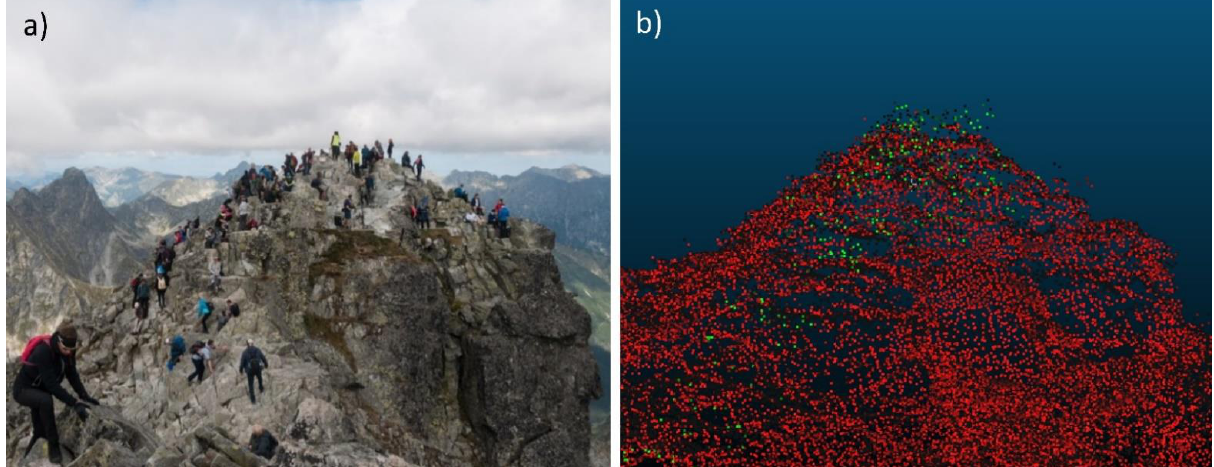
Figure 6. Rysy: ( a ) photo taken in summer season; ( b ) Slovak ALS point cloud with Unclassified (green) and Ground (red) points. Source: authors. Table 7. Measurement results obtained with the Xiaomi Mi 8